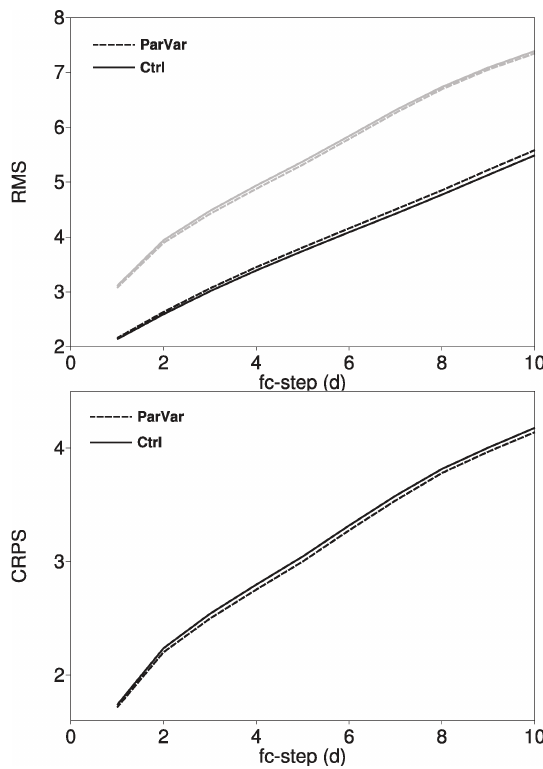
Fig. 5. Ensemble verification of the ensemble with parameter vari- ations (ParVar) and a control ensemble (Ctrl) that uses the same initial perturbations and model uncertainty representation but no parameter perturbations for the 200hPa zonal wind component in the tropics: (a) ensemble standard deviation (black) and ensemble mean RMS error (grey); (b) Continuous Ranked Probability Score. Sample of 90 cases in the period 24 June, 12:00UTC to 8 August,